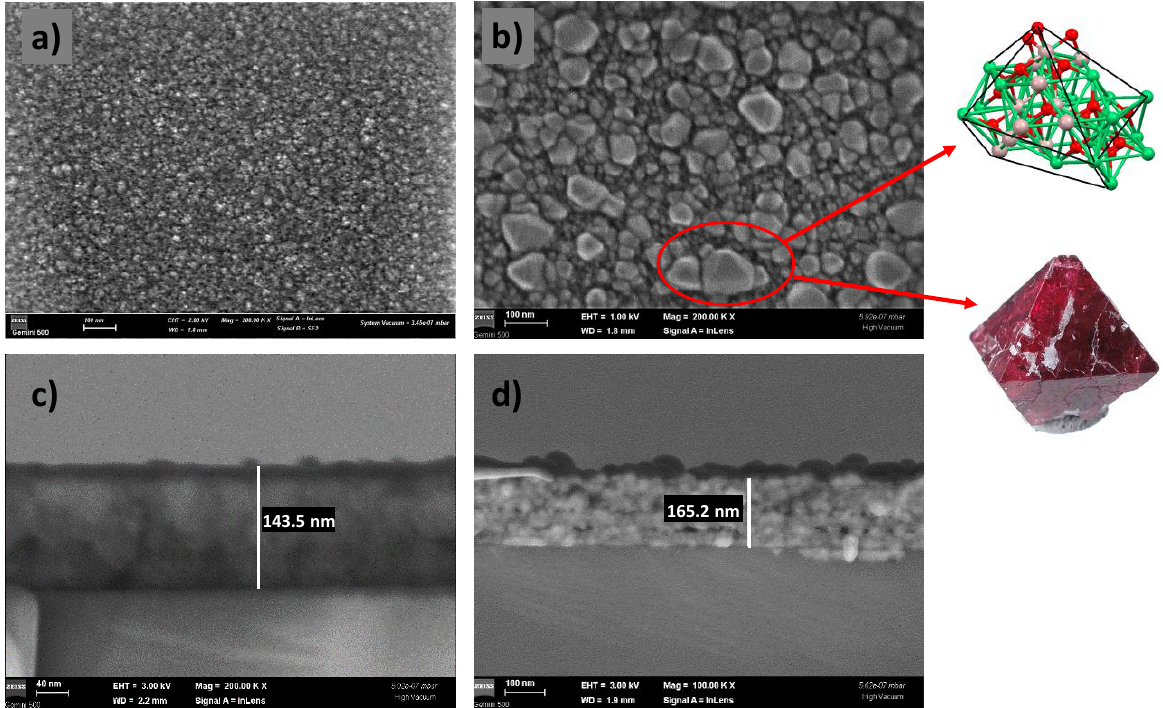
Figure 3. SEM images of the CoNiAl samples, before ( a ) and after ( b ) annealing, with cross-section details ( c , d ).